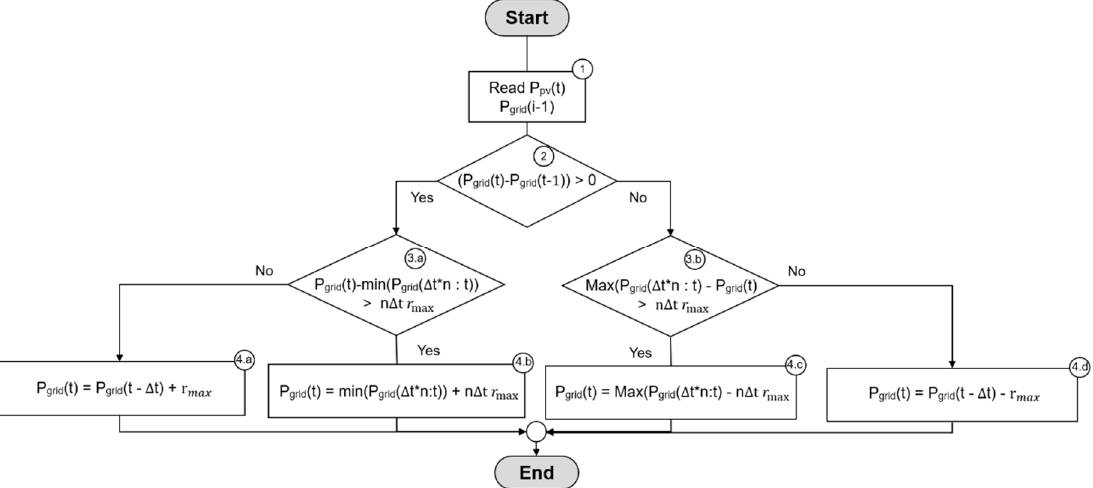
Figure 7. Strategy 2 Flowchart.